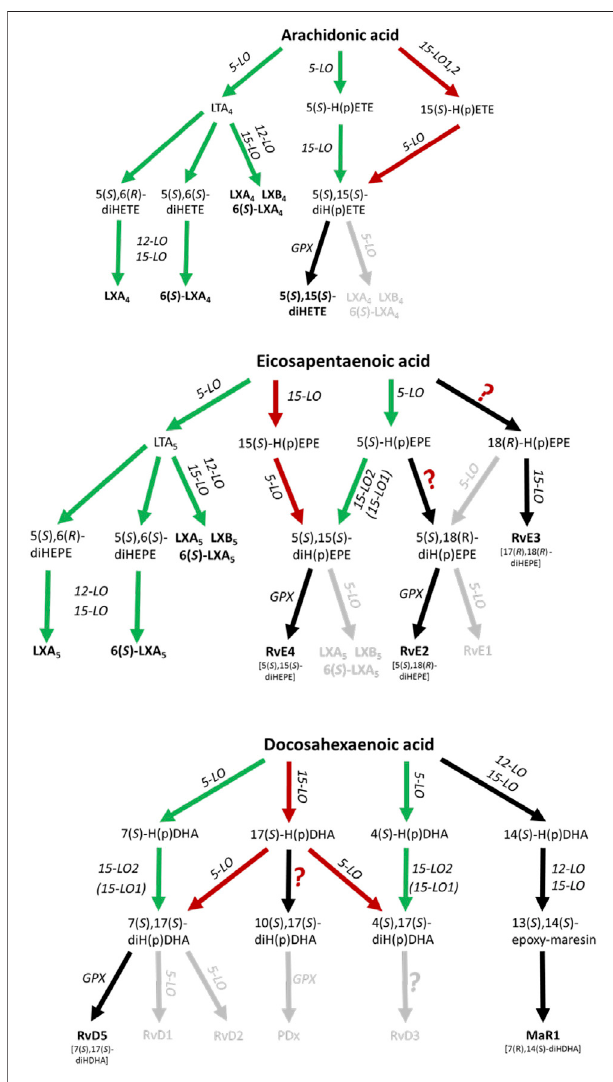
FIGURE 1 | Scheme of human leukocyte-dependent SPM formation fromAA,EPAandDHAwhereSPMswithsigni fi cantformationarehighlighted. The 5-LO:12/15-LO pathway is shown in green and the 12/15-LO:5-LO pathway is depicted in red. Inef fi cient SPM biosynthesis routes are grey colored. GPX, glutathione